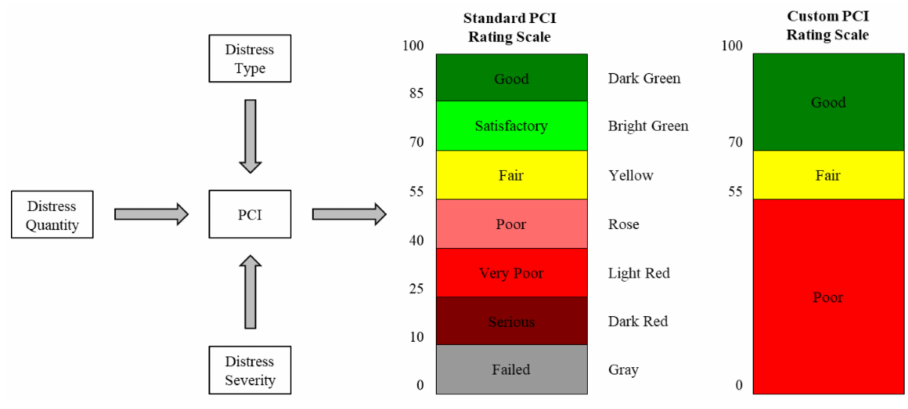
Figure 1. PCI indicator scale